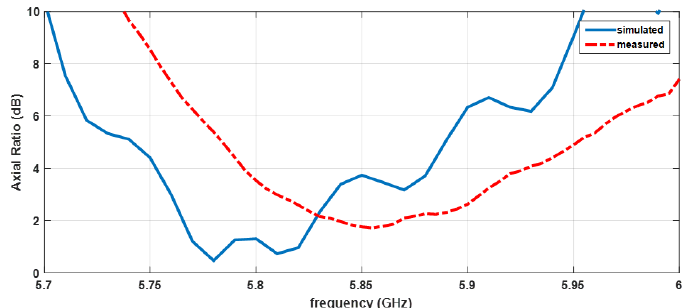
Figure 12. Simulated and measured axial ratio of the antenna with the frequency.